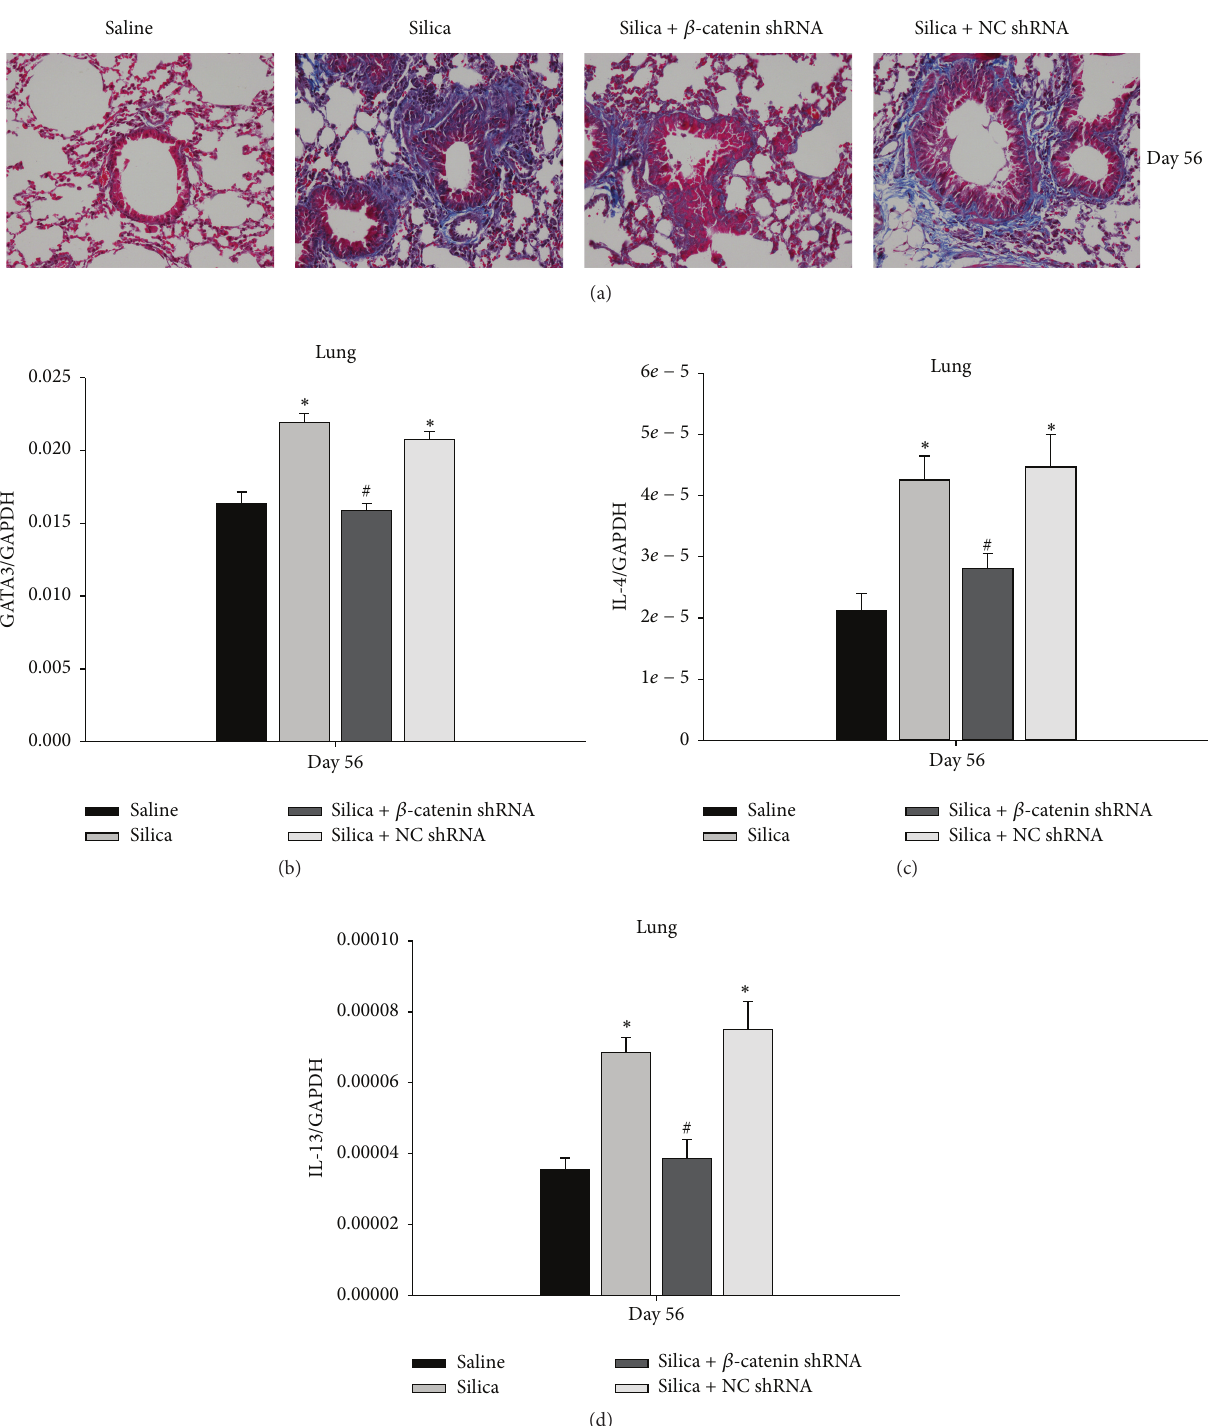
Figure 7: Blockade of Wnt/ 𝛽 -catenin pathway alleviated silica-induced fibrosis. (a) Lung sections from C57BL/6 were stained with Masson trichrome staining and observed under the light microscope (magnifications × 200). Expressions of GATA3 (b) and IL-4 and IL-13 (c) in the lung were assayed by real-time RT-PCR using the −ΔΔ Ct method. Values are shown as mean ± SEM ( 𝑛 = 4 -5) ( ∗ , as compared with saline group, 𝑝 < 0.05 ; #, as compared with silica group and silica + NC shRNA group, 𝑝 < 0.05